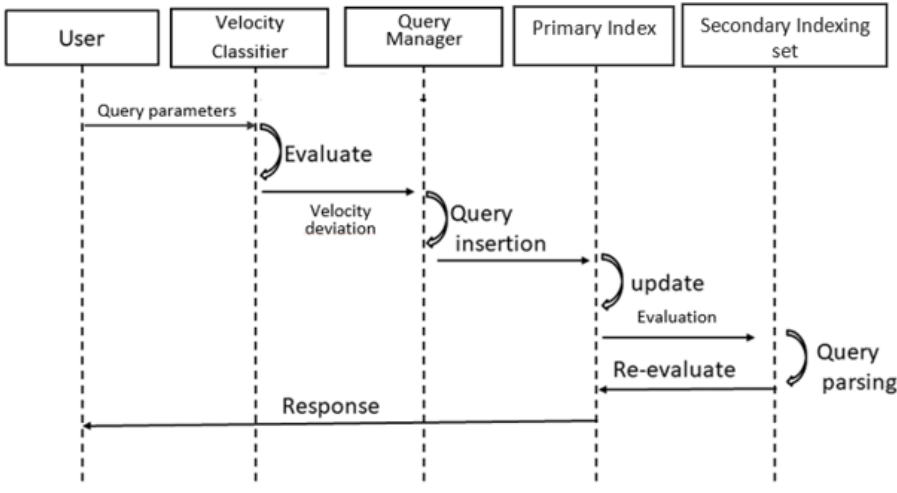
Figure 1. Sequence diagram of CKNN query processing.